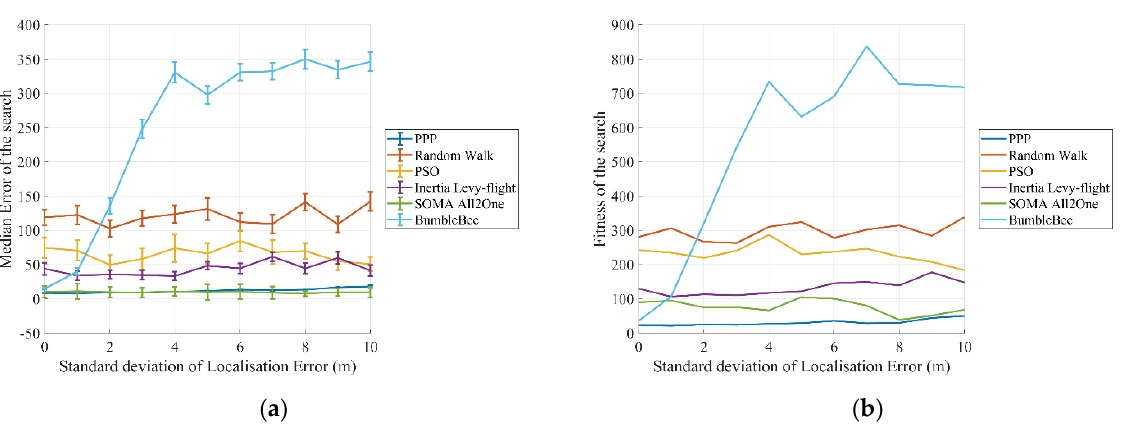
Figure 23. Median performance ( a ) and fitness ( b ) of different search strategies under the influence of increasing localisation error.